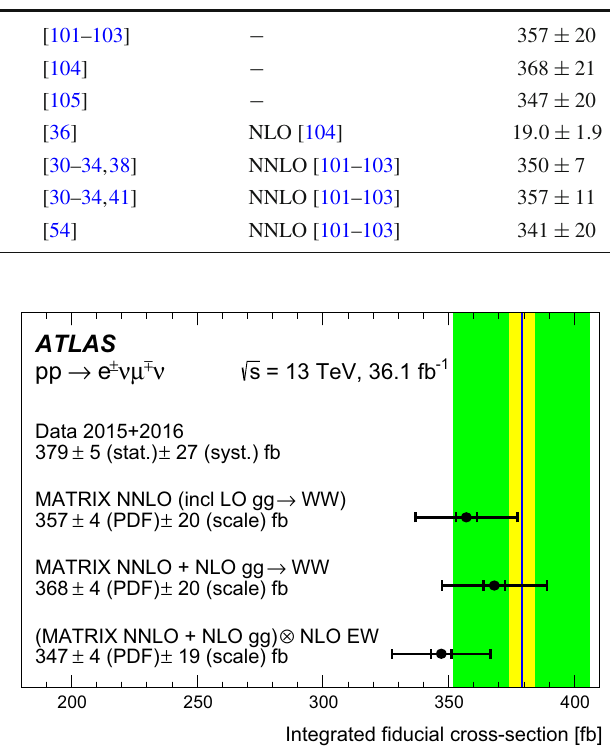
Fig. 5 Comparisonofthemeasuredfiducialcross-sectionwithvarious theoretical predictions. Theoretical predictions are indicated as points with inner (outer) error bars denoting PDF (PDF+scale) uncertainties. Thecentralvalueofthemeasuredcross-sectionisindicatedbyavertical line with the narrow band showing the statistical uncertainty and the wider band the total uncertainty including statistical and systematic uncertainties